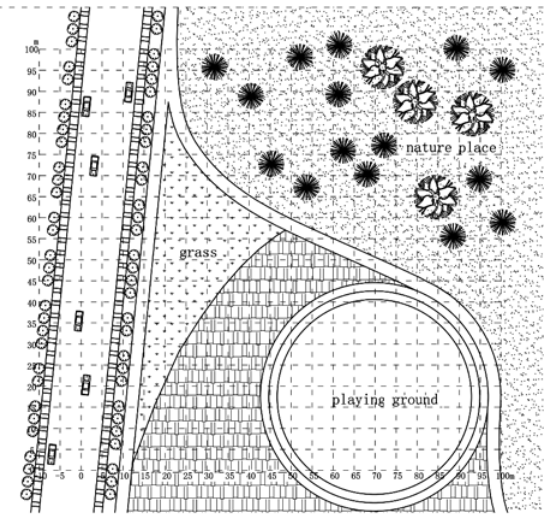
Fig. 7. A hypothetic open square regarding a real situation